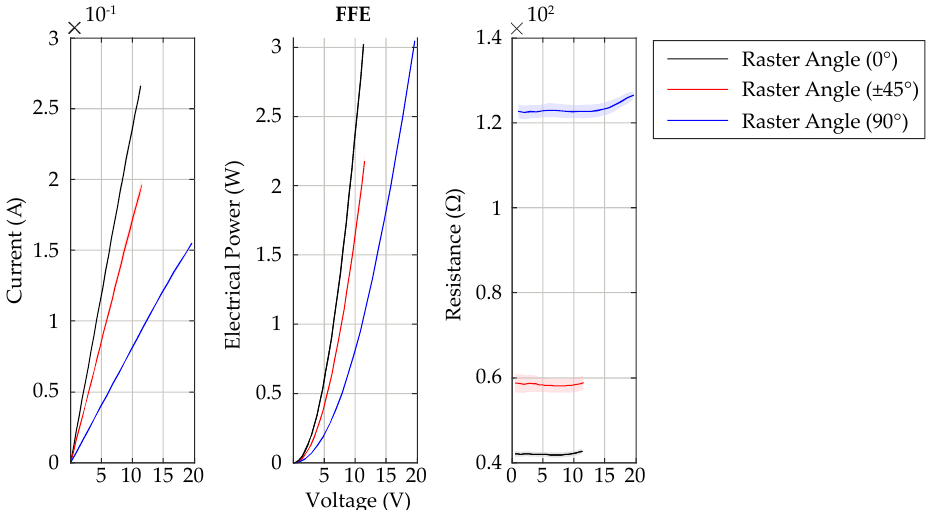
Figure 19. Representation of current, electrical power and resistance depending on voltage of FFE.